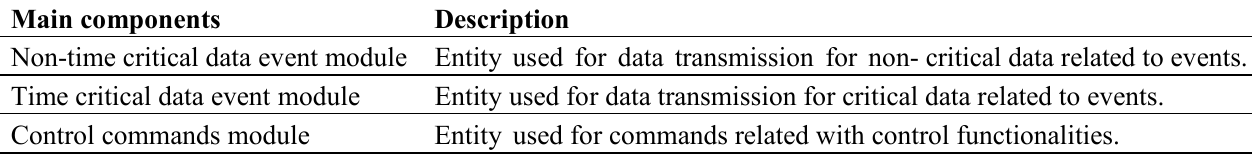
Table 10. Description of Secure Decentralized Data-Centric Information Infrastructure main